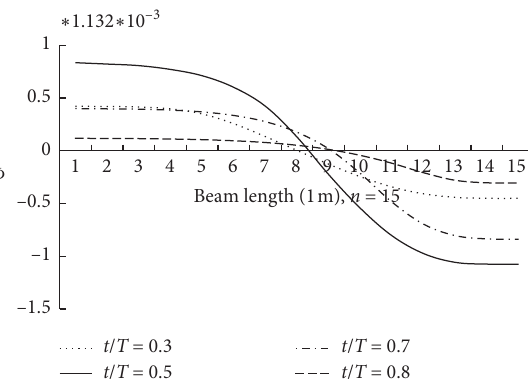
Figure 14: S-S T Beam (1) cross-section rotation.